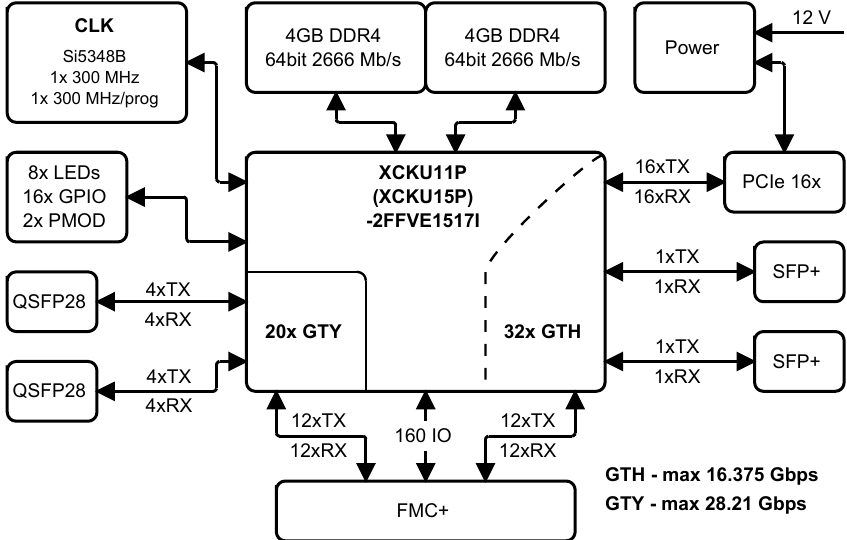
Figure 2. The block diagram of developed field-programmable gate array (FPGA) card.